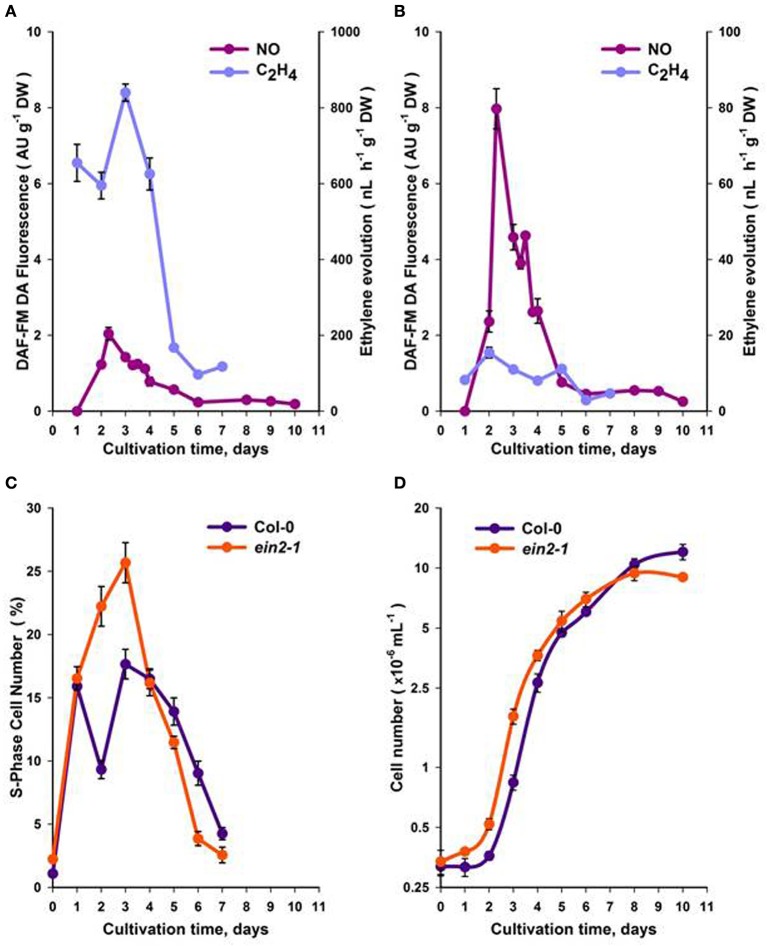
Production of NO and ethylene within a sub-cultivation period of Col-0 (A) and ein2-1
(B) cultures. The portion of S-phase cells (C) and the total cell number (D). On (D), the ordinate axis is represented in a log scale. All values (means ± SE) are the averages of three independent biological experiments with five analytical replicates.